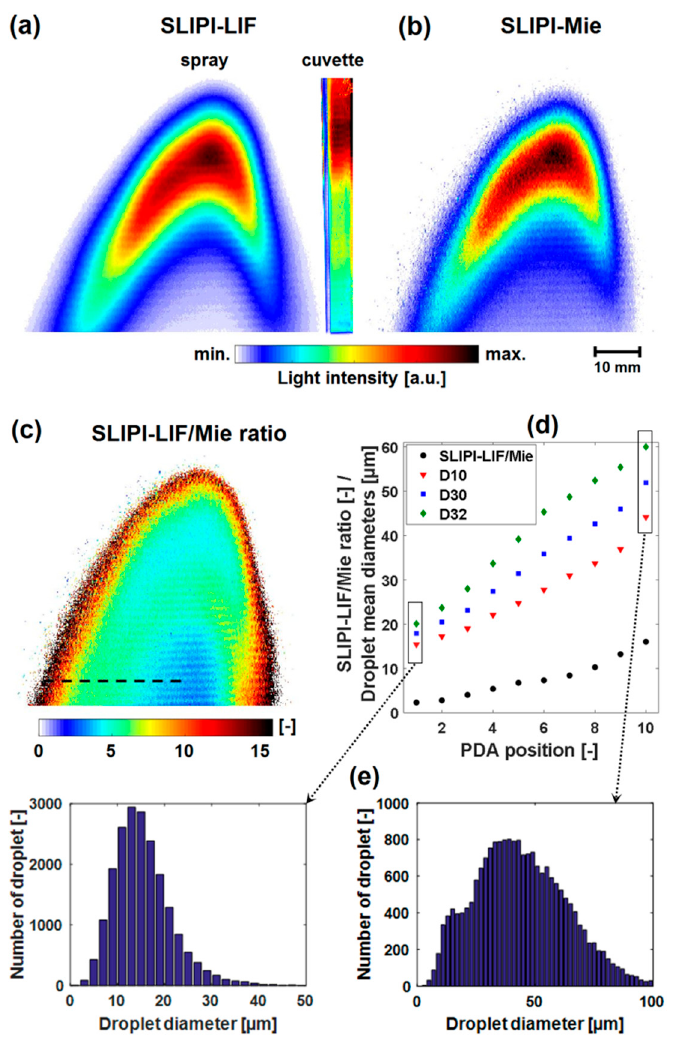
Figure 4. ( a ) SLIPI-LIF image of the spray and the dye cuvette; ( b ) SLIPI-Mie image; ( c ) SLIPI-LIF / Mie ratio image of the spray; the PDA measurements are plotted in ( d ) against the SLIPI-LIF / Mie ratio and droplet mean diameters; ( e ) histograms of droplet size distributions measured using